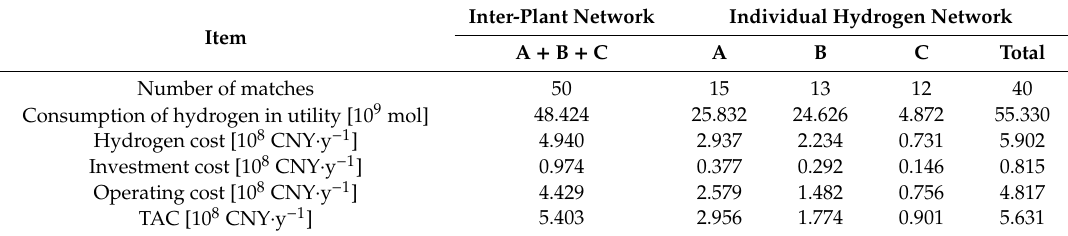
Table 3. Comparison of the inter-plant integration and individual plant integration.